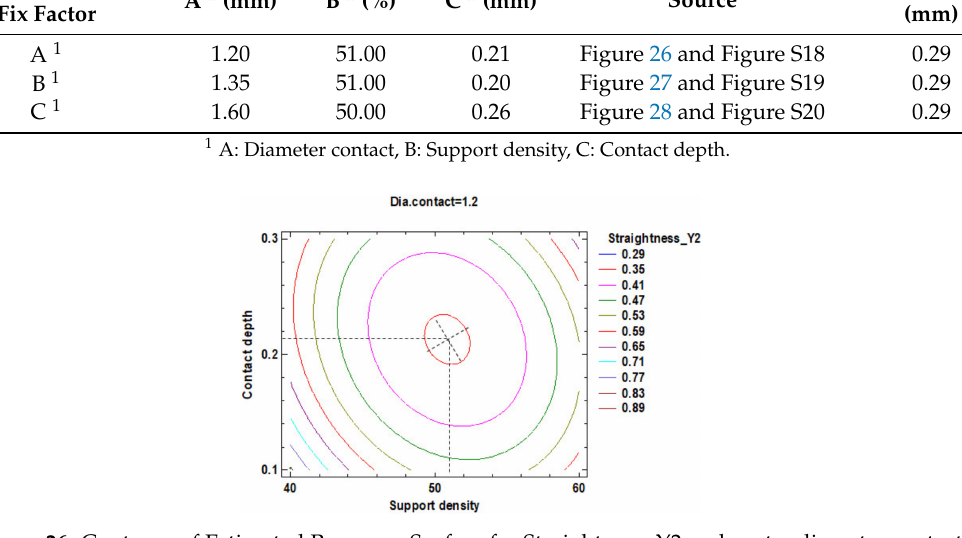
Figure 26. Contours of Estimated Response Surface for Straightness_Y2 and centre diameter contact.